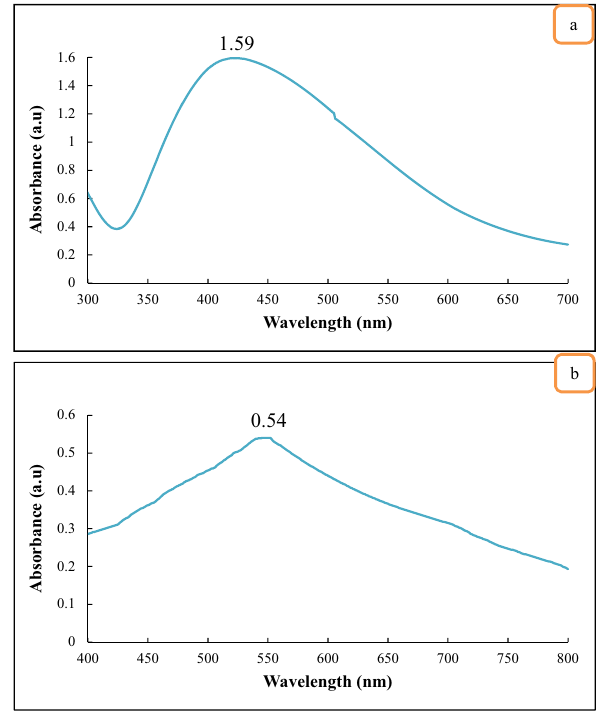
Figure 2: UV - Visible spectra of: ( a ) Ag NPs, ( b ) Cu